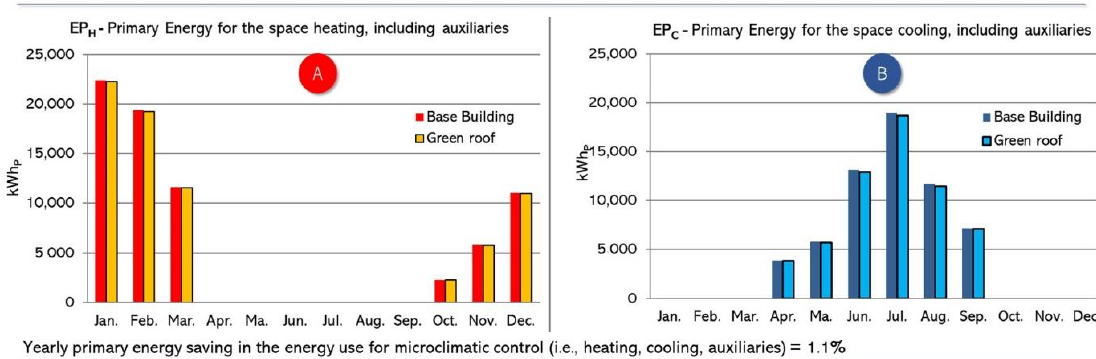
Figure 9. HVAC Heating and cooling primary energy demand, before and after the green roof addition.